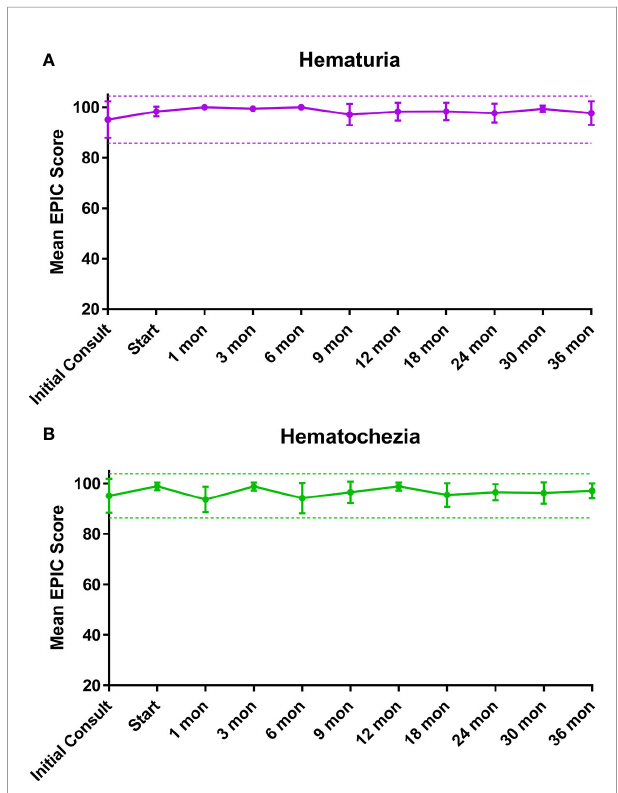
FIGURE 1 | Mean summary scores at baseline and following SBRT for prostate cancer. (A) Hematuria. (B) Hematochezia. Thresholds for clinically signi fi cant changes in scores (½ standard deviation above and below the baseline) are marked with dashed lines. EPIC scores range from 0 – 100 with higher values representing a more favorable health-related